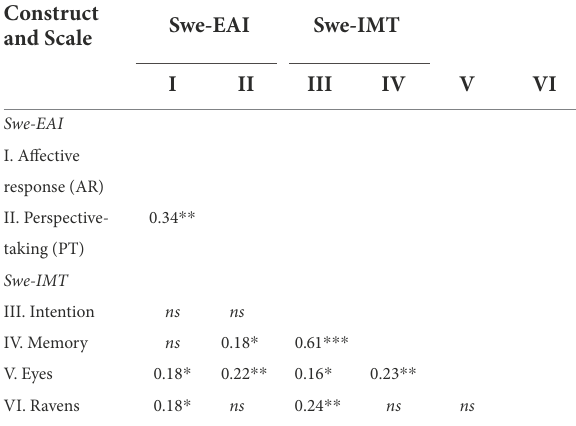
TABLE 2 Statistically significant Pearson inter-correlations between the four